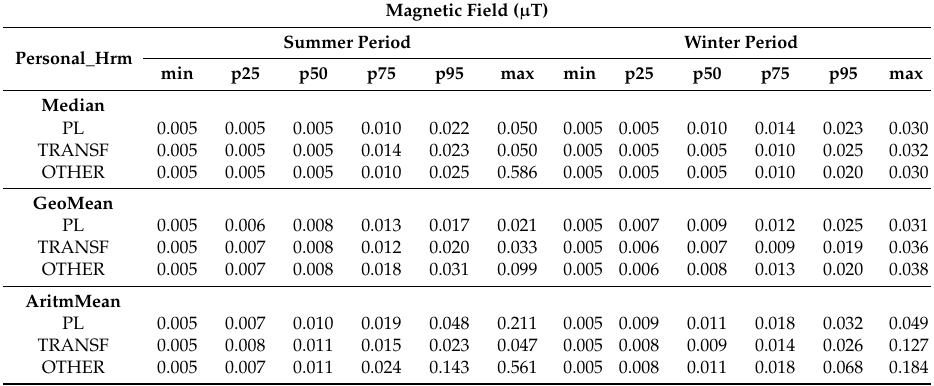
Table A3. Distribution values of the median, geometric mean (geomean) and arithmetic mean (aritmean) of magnetic field ( µ T) in the harmonic (Hrm) frequency range (100–800 Hz) for personal measurements for each group (PL, TRANSF, OTHER) in both summer and winter periods.